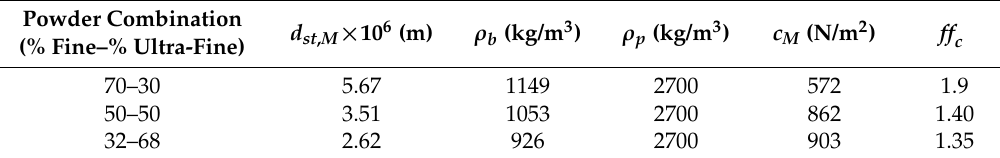
Table 3. Properties of the powder mixtures used in this study.